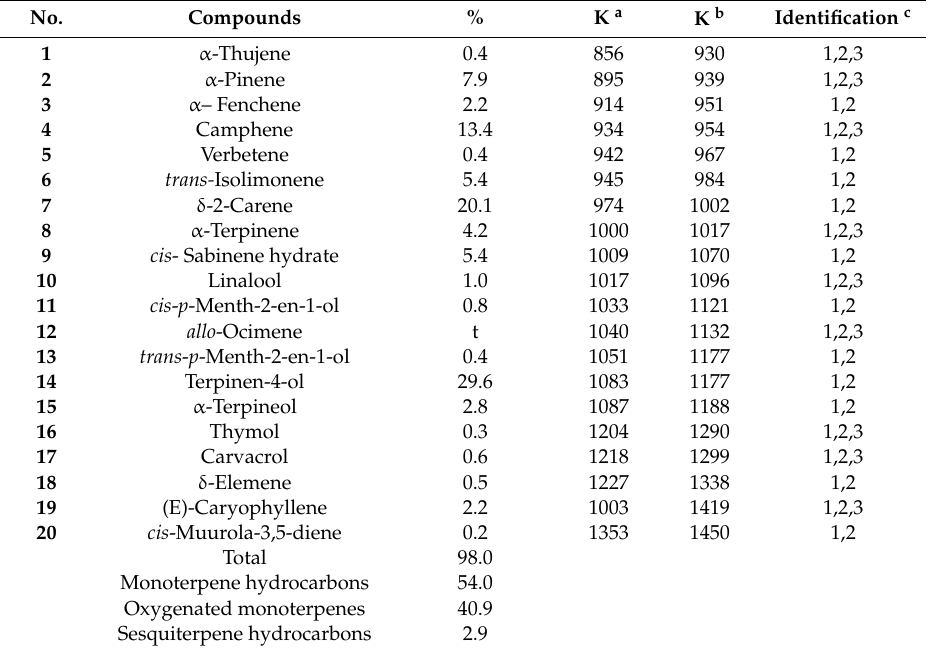
Table 2. Chemical composition of O. majorana essential oil.